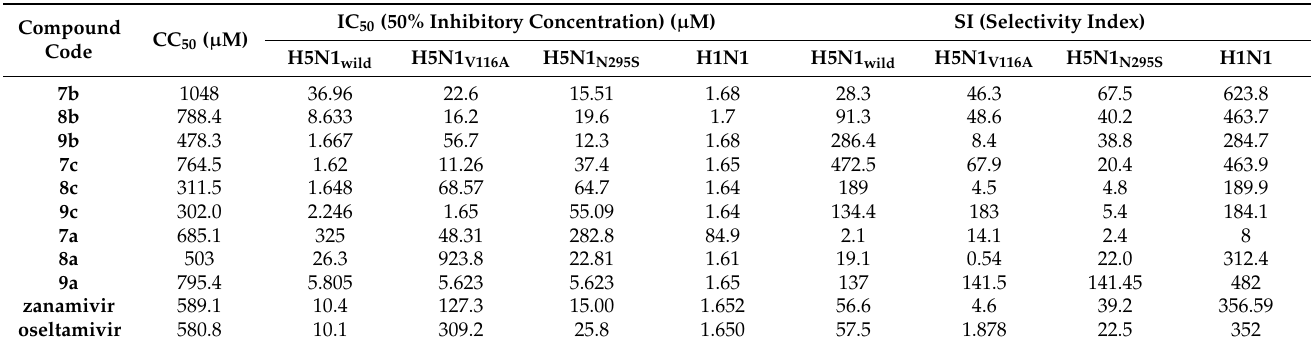
Table 1. CC 50 , IC 50 , and SI for new synthetic compounds and standard NAIs against H5N1 wild , H5N1 V116A , H5N1 N295S , and H1N1 viruses. Compound Code